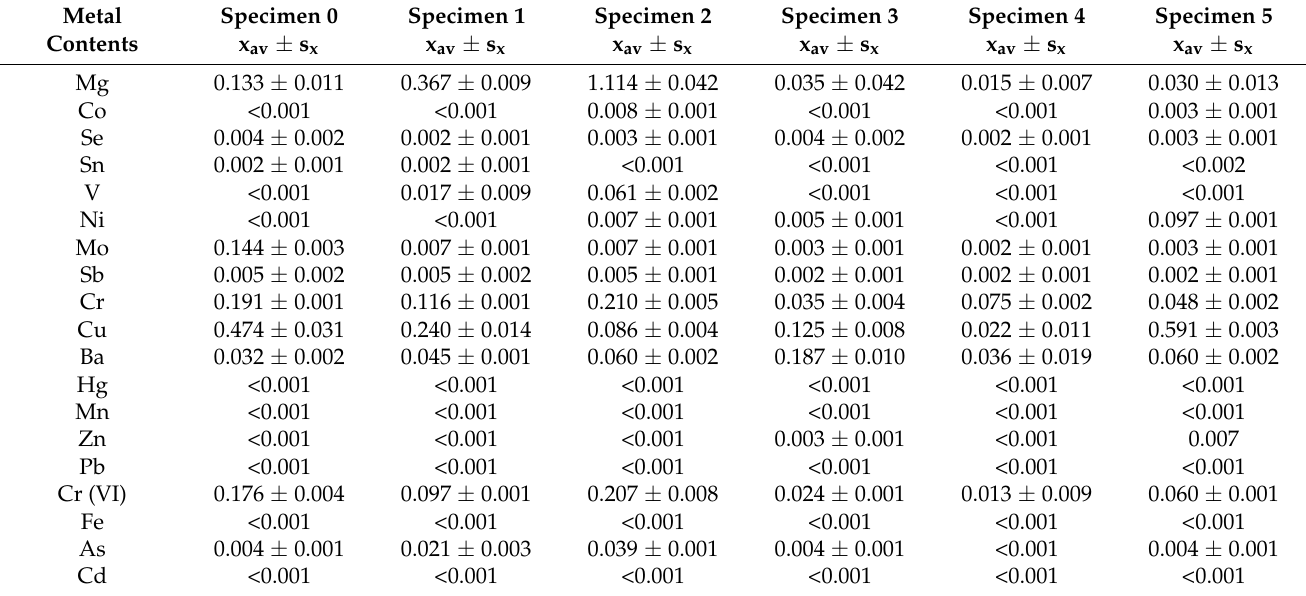
Table 11. The total metal content in the leachants of the concrete specimens taken from the bridge above the Kłodnica river in Gliwice, in